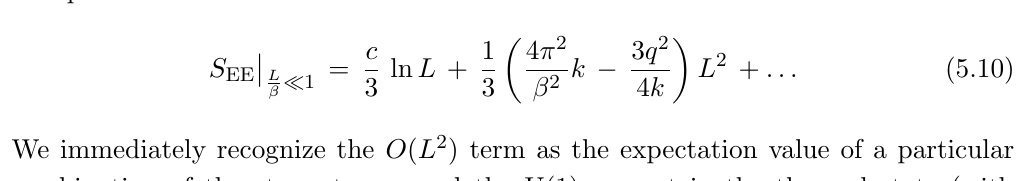
charges versus the U(1) charge q for holographic 2 + (cid:0) has extrema when q 2 = 4 G G